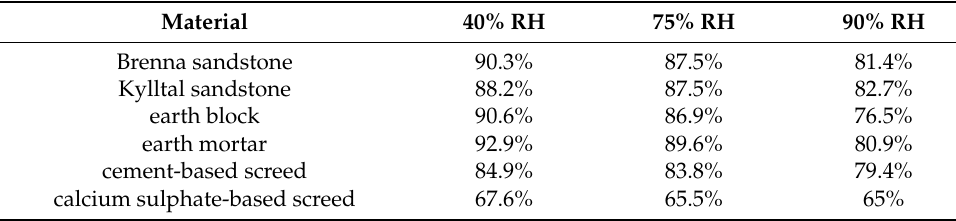
Table 5. Moisture located in mesopores compared to the overall